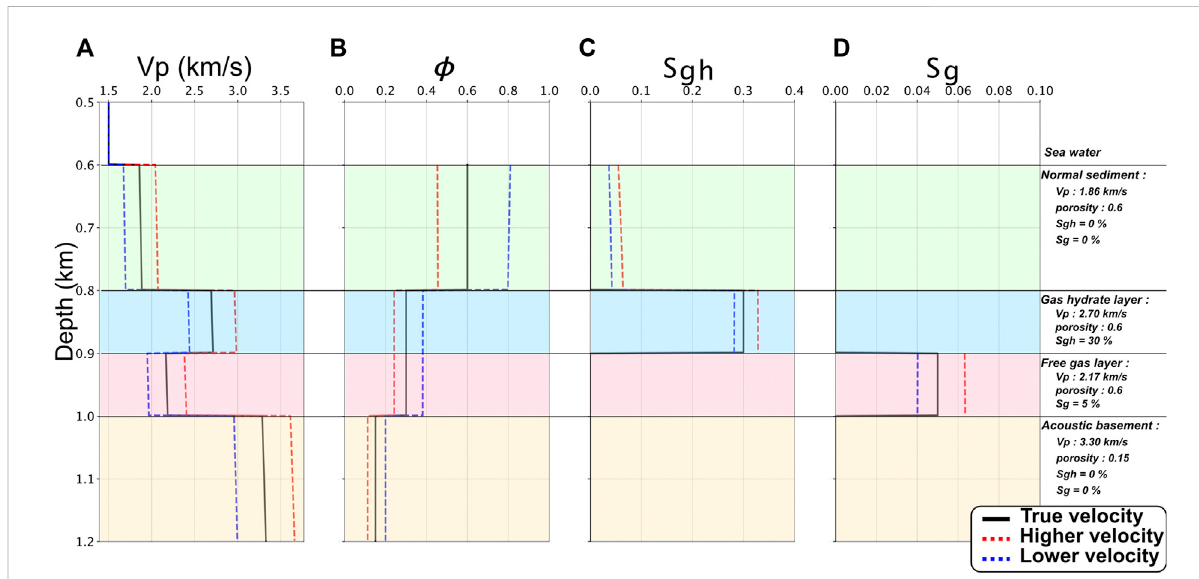
FIGURE 8 Theresultsofthequanti fi ederroranalysis (A) 4-layervelocitypro fi les (B) calculatedporosity-depthpro fi les (C) estimatedgashydratesaturation pro fi les, and (D) estimated free gas saturation pro fi les. The black solid line is the true velocity. The dashed line is the 10% higher (red) and 10% lower (blue) velocity than the true